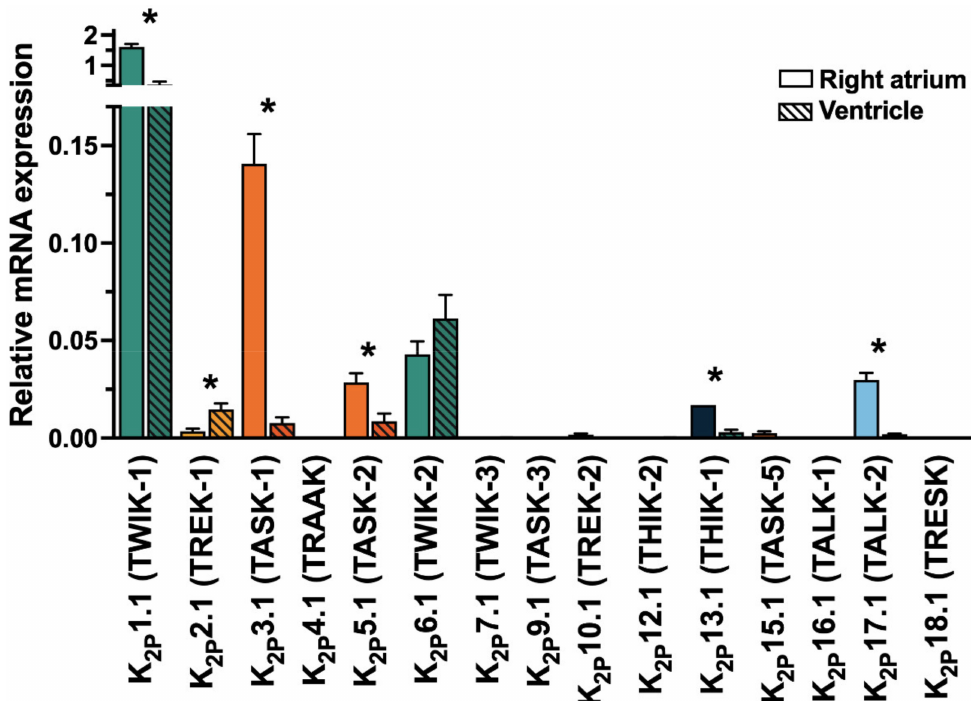
Figure 2. Cardiac mRNA levels of K 2P channels in the human heart (whole tissue). Expression of two-pore-domain potassium (K 2P -) channel mRNA level in human right atrial ( n = 10) and left ventricular ( n = 5) tissue samples. Data are given as mean ± SEM relative to the housekeeping gene importin 8 ( IPO8 ). * indicate p < 0.05 from Student’s t-tests. Data from Schmidt et al. 2015, Circulation